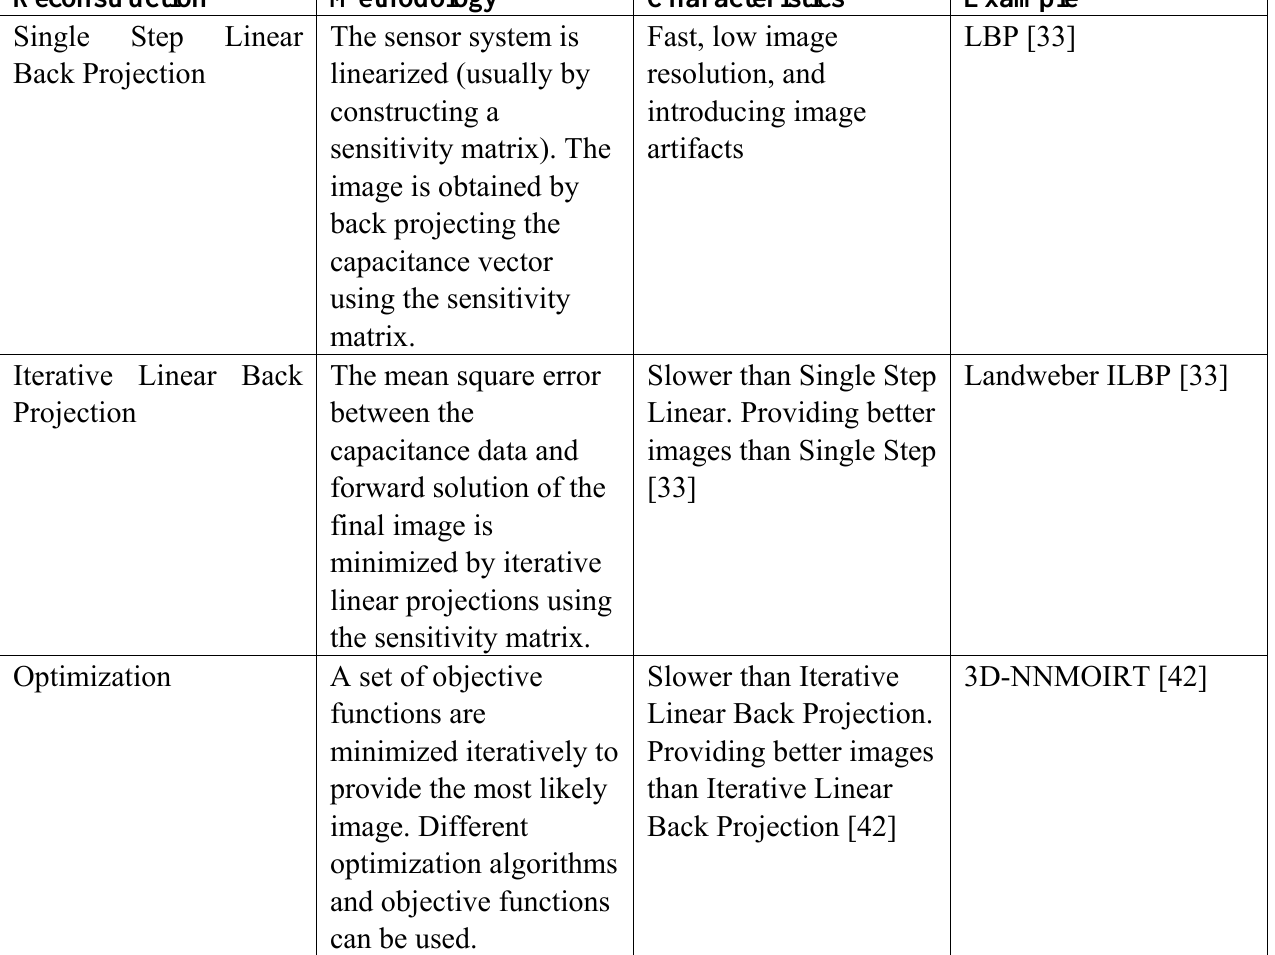
Table 1 . Key techniques used in solving the inverse problem of capacitance tomography.